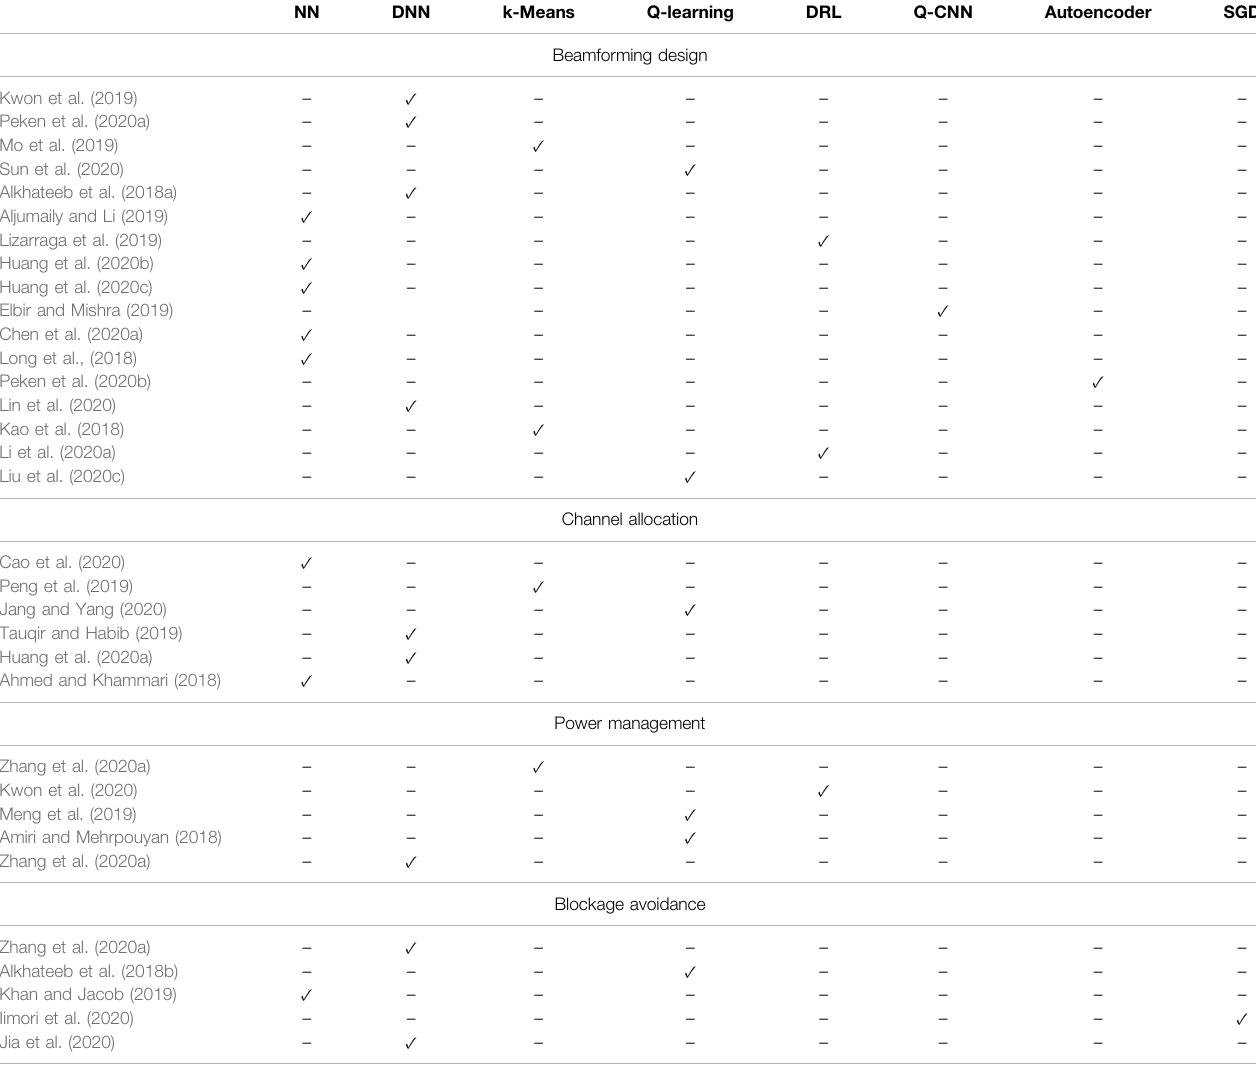
TABLE 3 | ML algorithm types applied in